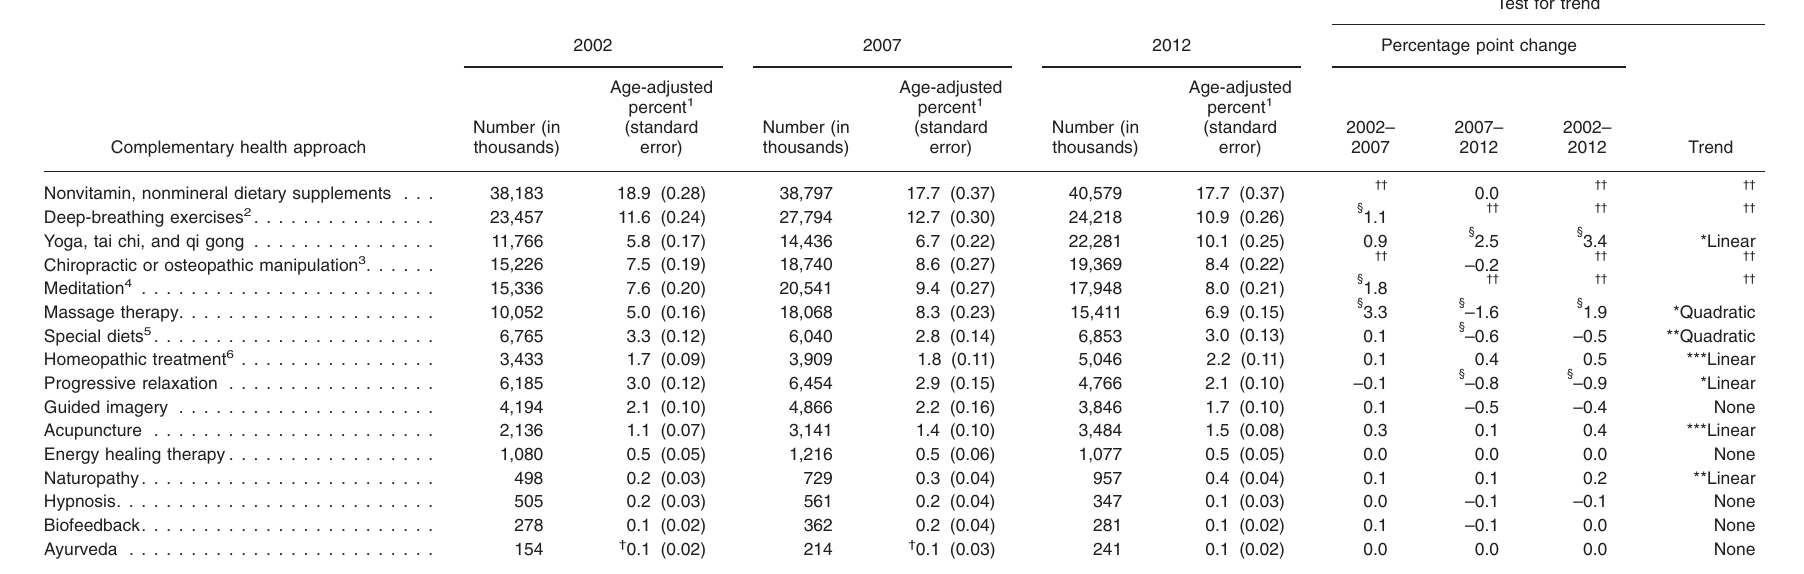
Table 1. Trends in the use of selected complementary health approaches during the past 12 months, by type of approach: United States, 2002, 2007, and